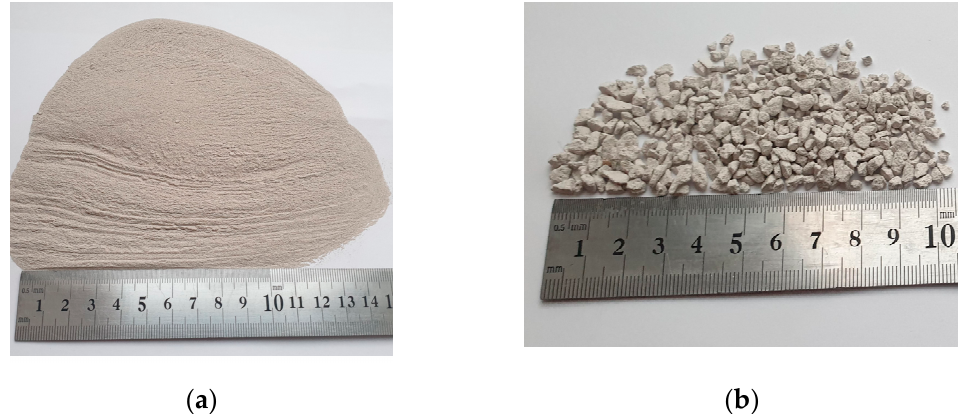
Figure 7. Photograph of the: ( a ) zeolitic by-product; ( b ) coarser fraction of sorption material based on straetlingite.